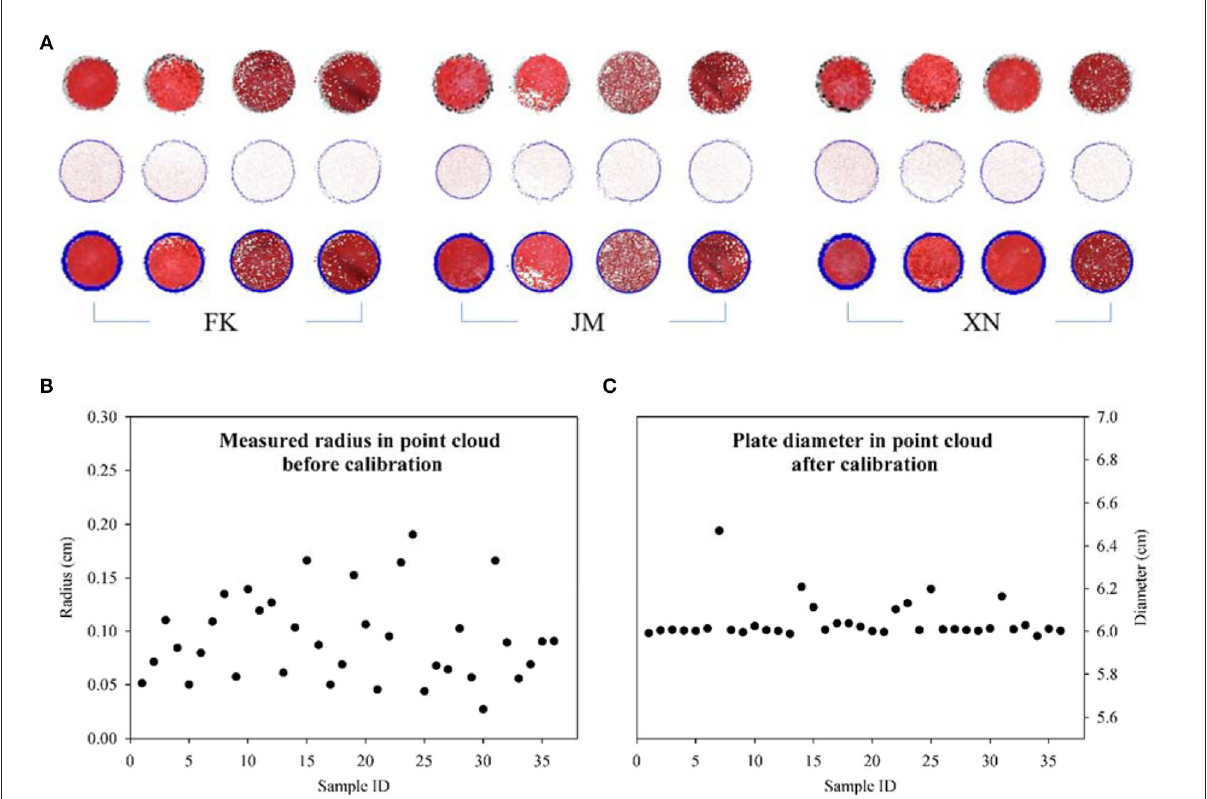
FIGURE9 Visualization results and error comparison of marker plate measurements. (A) Identified marker plate and radius estimation. Three rows represent segmented marker plate points, extracted boundary points, and fitted circumcircle, respectively. (B) The measured radius of marker plate before point cloud calibration. (C) Measured diameter of marker plate after point cloud calibration. Errors of calibrated diameters occur because the marker plate being partly covered by wheat